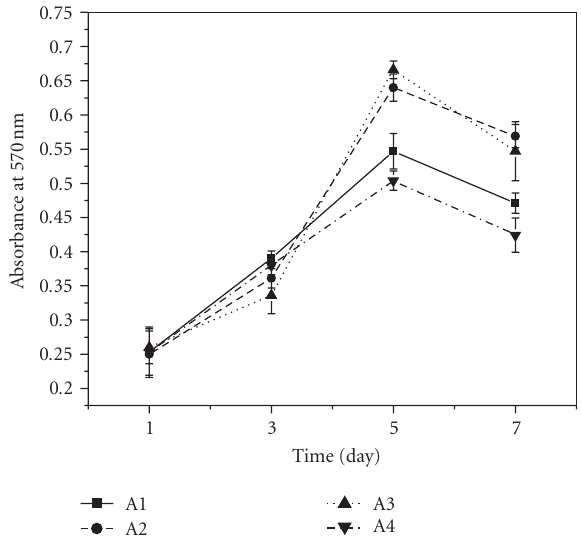
Figure 10: E ff ect of PLGA microsphere incorporation on murine L929 cells proliferation on gelatin sca ff old. Proliferation was studied for 7 days. Values are mean ± S.D. ( n = 3). (A1) Gelatin sca ff old, (A2) 0.1% w/w PLGA microsphere loaded sca ff old, (A3) 1%w/w PLGA microsphere loaded sca ff old, and (A4) 10%w/w PLGA microsphere loaded sca ff old. ∗ P < . 05, compared to gelatin sca ff old having no PLGA